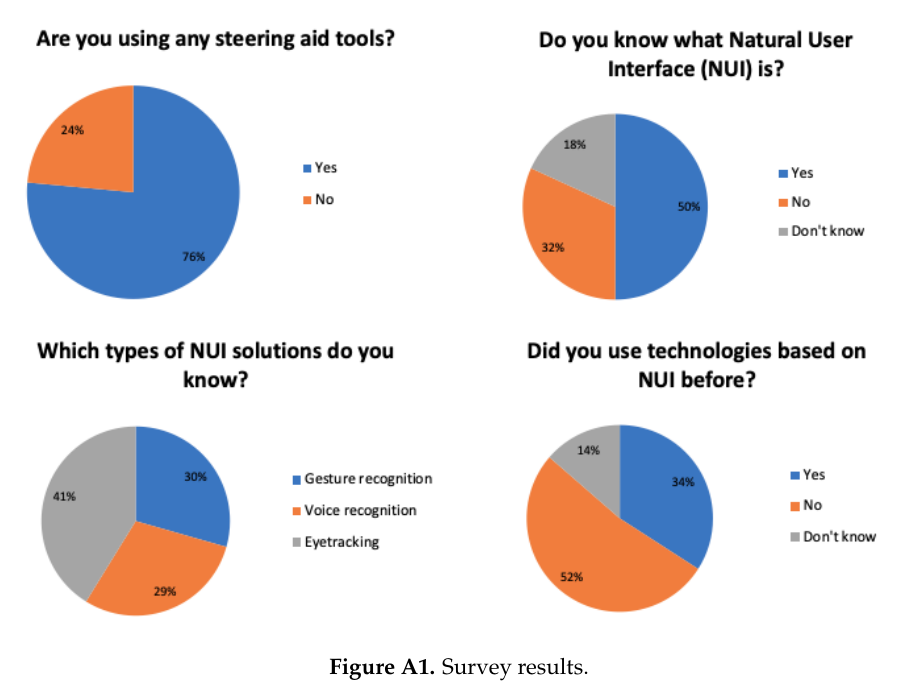
Figure A1. Survey